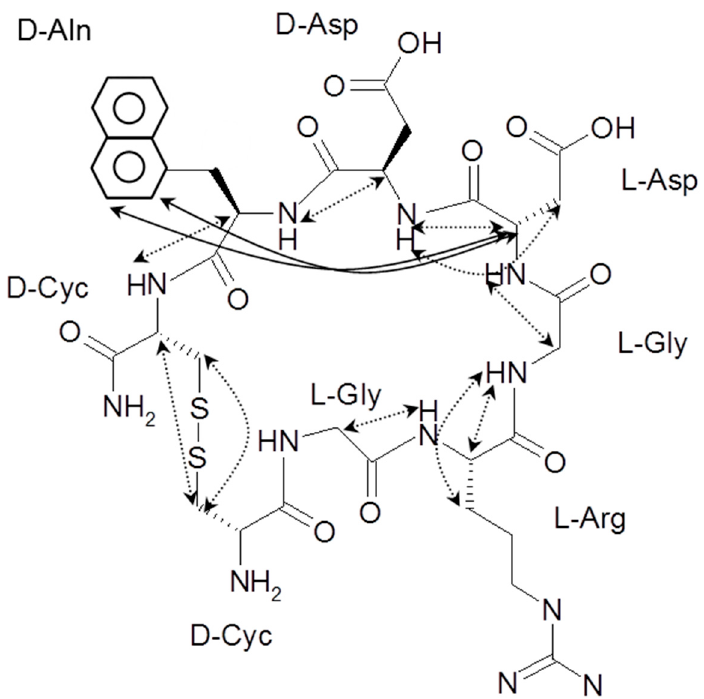
Figure 1. The observed NOEs of LXW64 in 2D 1H-1H NOESY (dashed lines for sequential NOEs; solid lines for long-range NOEs).